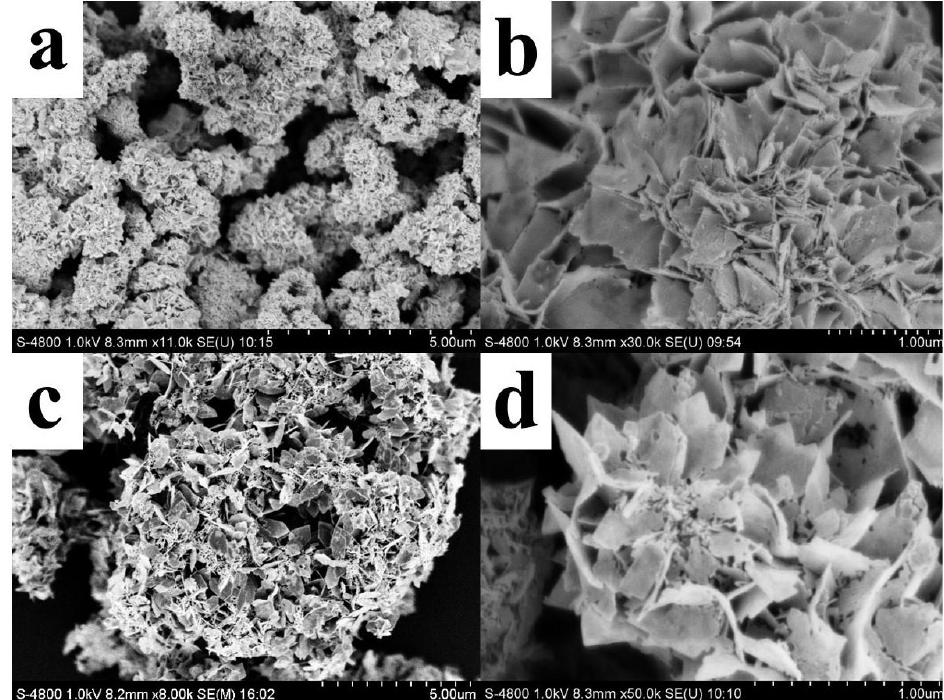
Figure 1. SEM images of SnO 2 nanoflowers before and after heat treatment. Low magnification SEM images ( a , c ) and high magnification SEM images ( b , d ) before and after calcination at 400 °C.